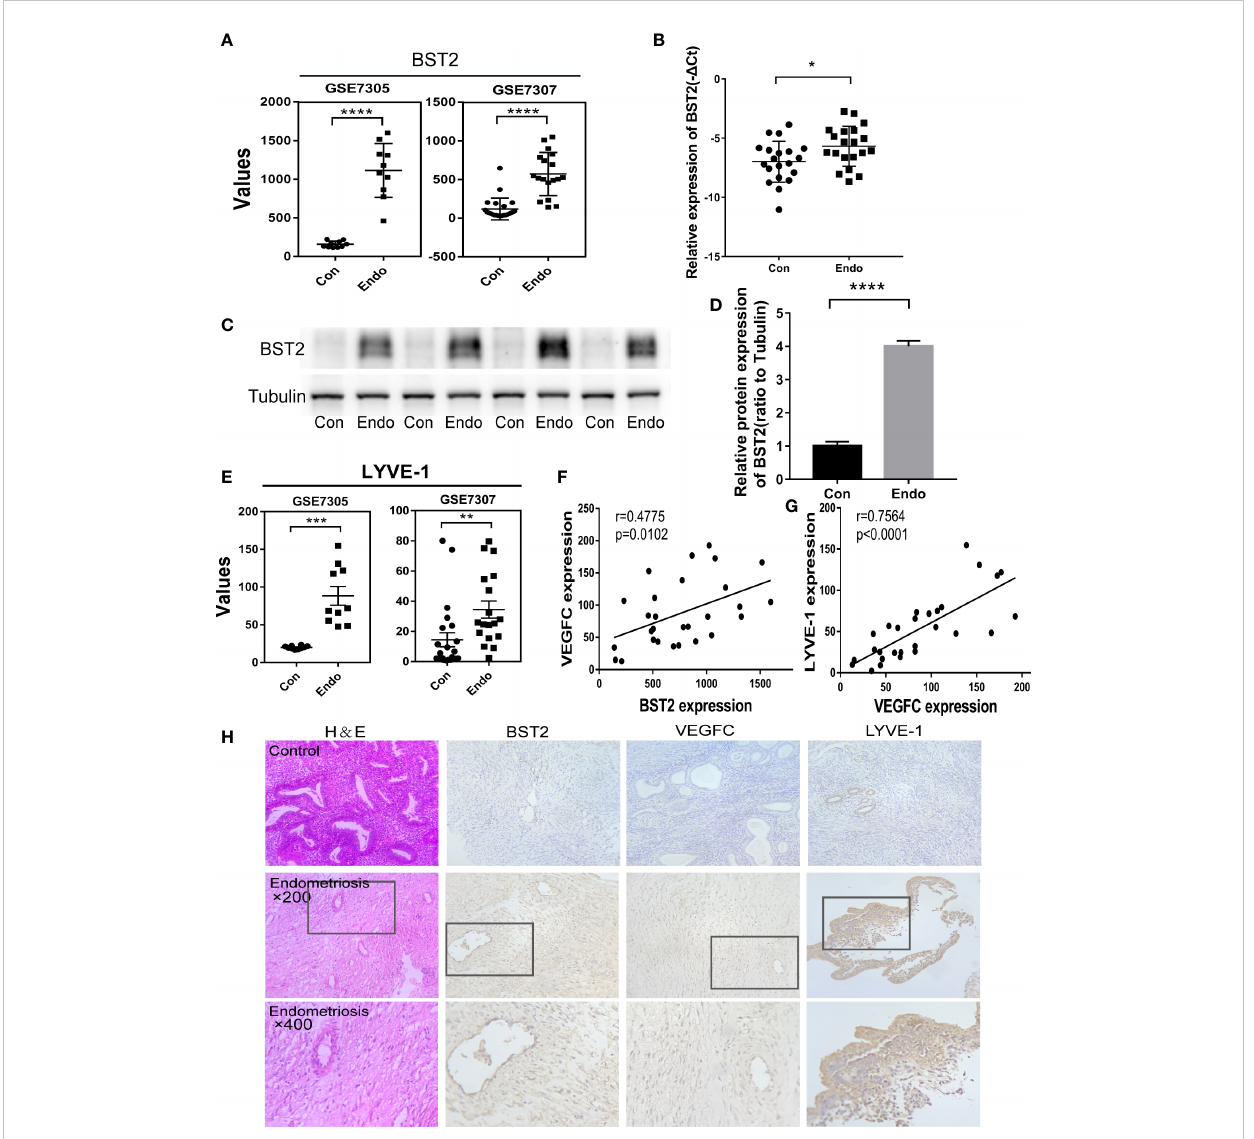
FIGURE 1 BST2 levels were overexpressed and positively correlated with the lymphangiogenesis in the endometriosis. (A) , BST2 expression levels in the GSE7305 and GSE7307 datasets. (B – D) , BST2 mRNA (B) and protein (C, D) expression in endometriosis samples. (E) , LYVE1 expression levels in the GSE7305 and GSE7307 datasets. (F) , The correlation of BST2 expression and VEGFC expression in the GSE7305 and GSE7307 datasets. (G) , The correlation of VEGFC expression and LYVE1 expression in the GSE7305 and GSE7307 datasets. (H) , (H, E) staining and Immunohistochemistry (IHC) of BST2, VEGFC and LYVE1 in endometriosis and control group. *p < 0.05; **p < 0.01; ***p < 0.001; ****p <